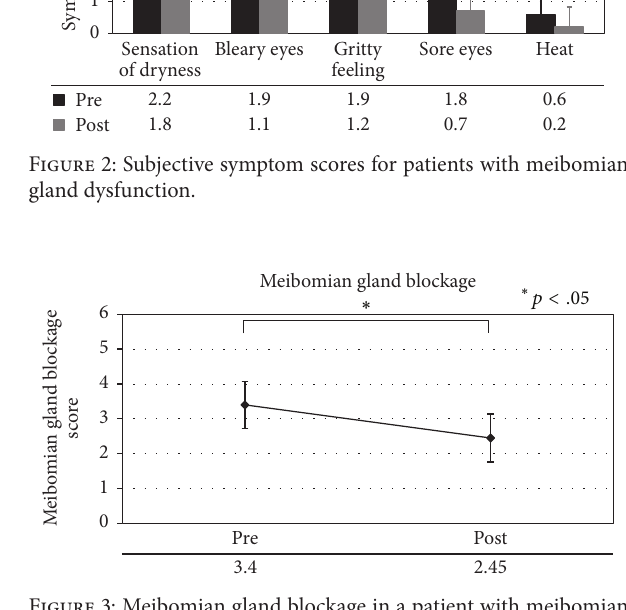
Figure 3: Meibomian gland blockage in a patient with meibomian gland dysfunction.